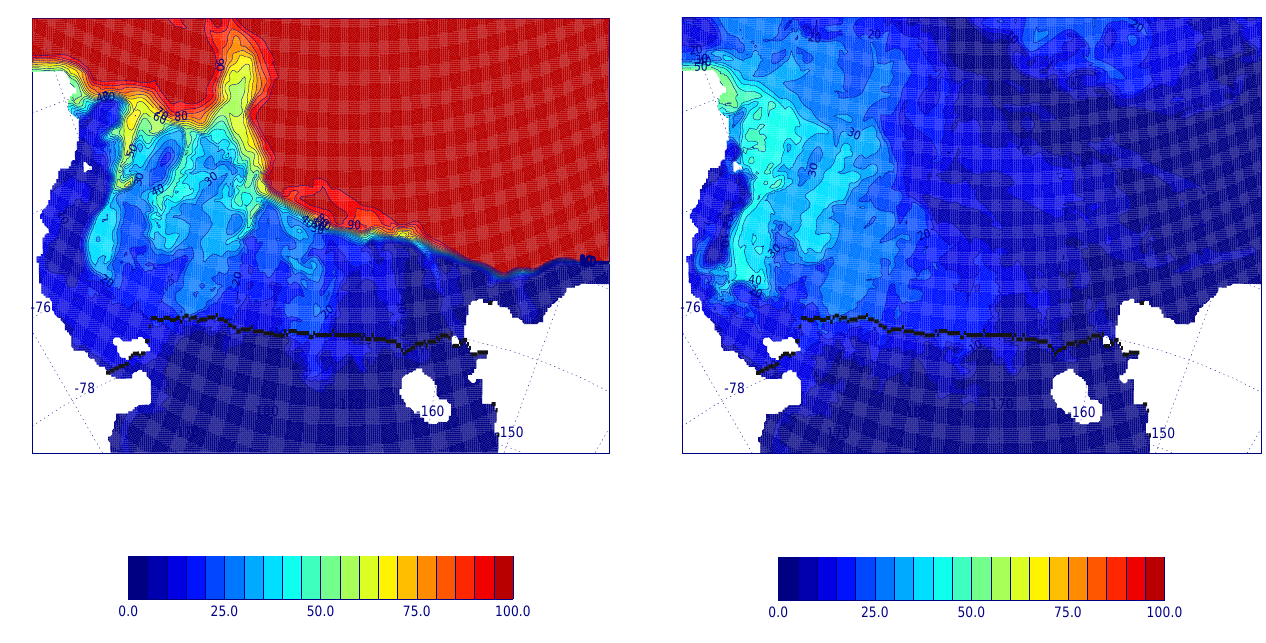
Fig. 7. CDW dye on the surface for 1 November 2002. Dye values of 100 are undiluted CDW. The black line represents the position of the Ross Ice Shelf